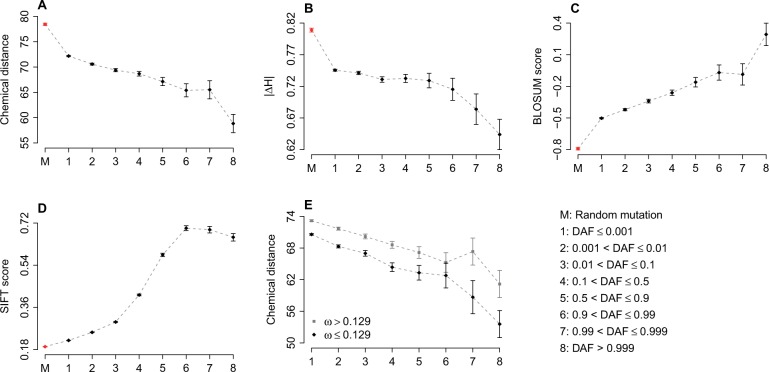
Functional effects caused by nonsynonymous SNPs as a function of DAF. (A) Amino acid chemical distance caused by nonsynonymous SNPs as a function of DAF; (B) Change in amino acid hydrophobicity index (|ΔH|) as a function of DAF; (C) BLOSUM62 scores as a function of DAF; (D) SIFT scores as a function of DAF; (E) Comparison of the functional effect caused by nonsynonymous SNPs between the genes undergoing stronger and weaker purifying selection. The median of ω (calculated using mouse orthologs) is used as the cutoff. Each point represents the mean of the corresponding category. Error bars indicate the standard error of the mean.